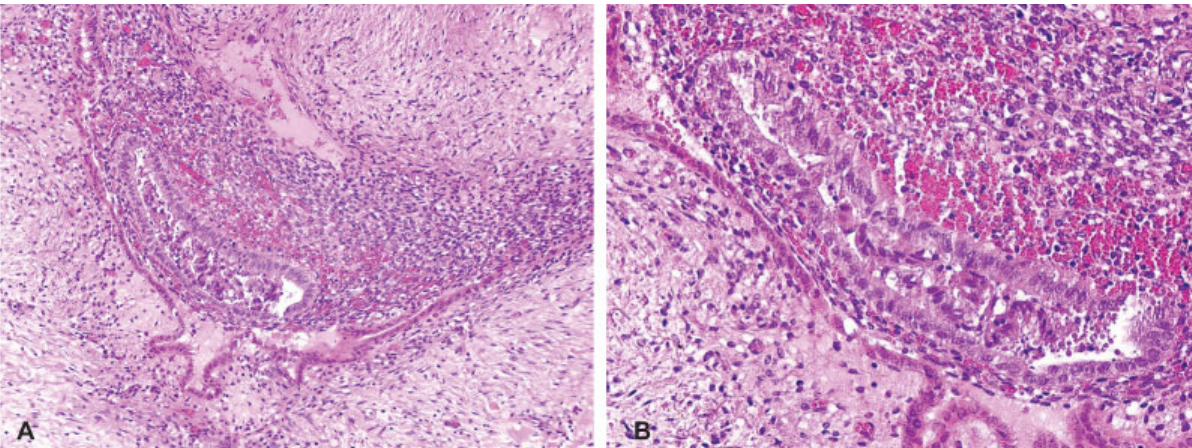
Fig.2 ( A , B ) Histologyof the umbilical lesion showingdense fi brosisand glandular structureslinedby simple columnarepithelium together with endometrial